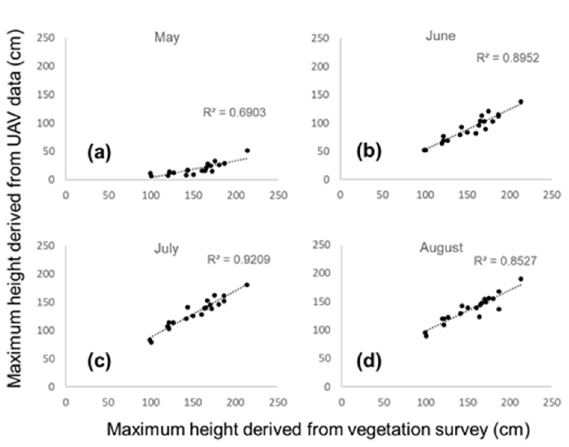
Figure 6. Comparison of maximum height of M. sinensis between UAV data: May (a), June (b), July (c) and August (d), and vegetation survey in September